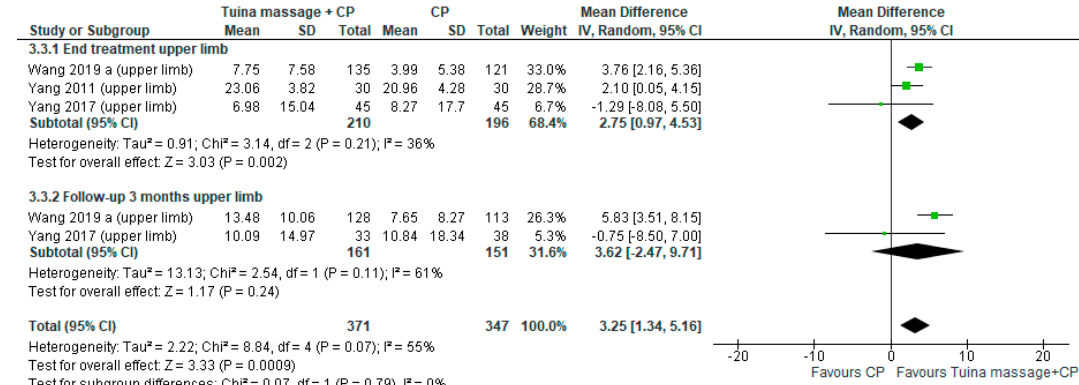
Figure 2. Forest plot of comparison Tuina massage plus conventional physiotherapy (CP) versus CP for motor function evaluated by Fugl Meyer Assessment Scale